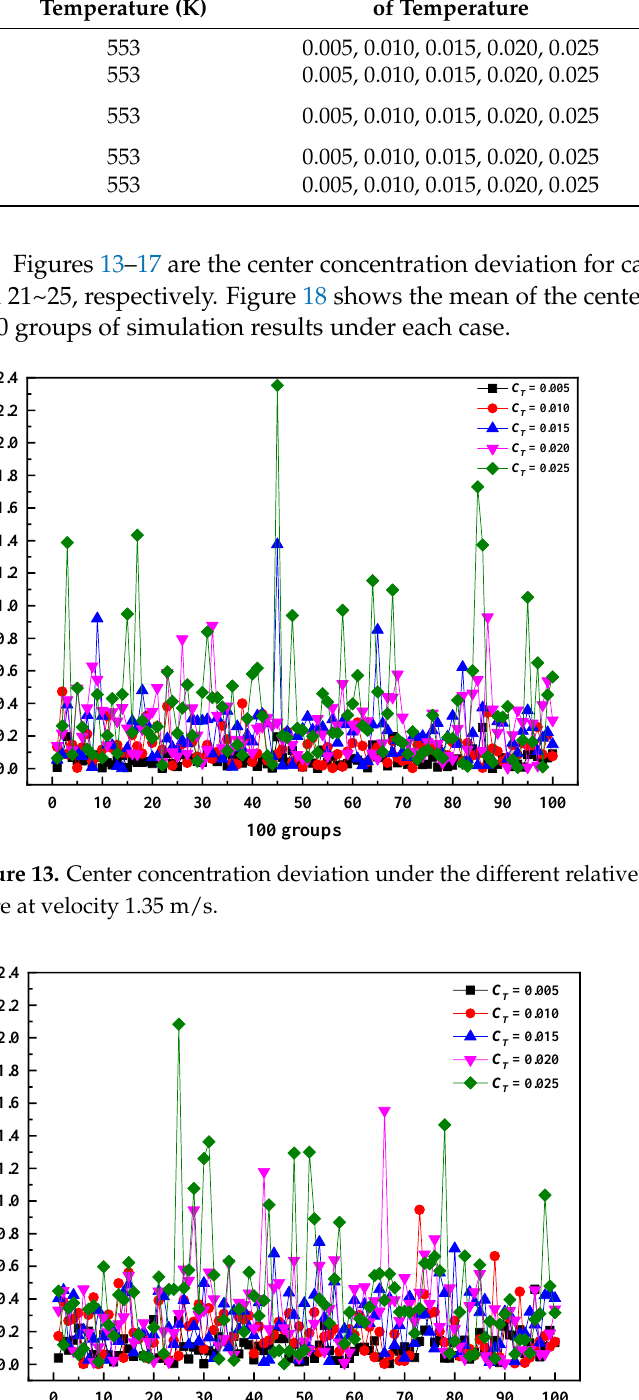
Figure 15. Center concentration deviation under the different relative standard deviations of tem- peratures at velocity 3.2 m/s. Figure 16. Center concentration deviation under the different relative standard deviations of tem- peratures at velocity 4.3 m/s.